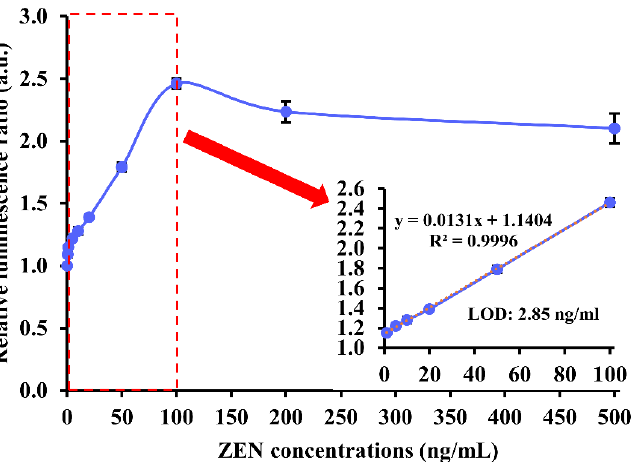
Figure 4. Analytical performance of our label-free chemiluminescence aptasensor in the presence of 0 – 500 ng/mL of ZEN target. The red dashed rectangle in the graph indicates the linear detection range of our aptasensor. The red arrow points to a magnifying graph showing the linear detection range of ZEN in 1 – 100 ng/mL and LOD of 2.85 ng/mL (or 8.95 nM). Table 1. Comparison of our chemiluminescence aptasensor with other reported analytical methods.